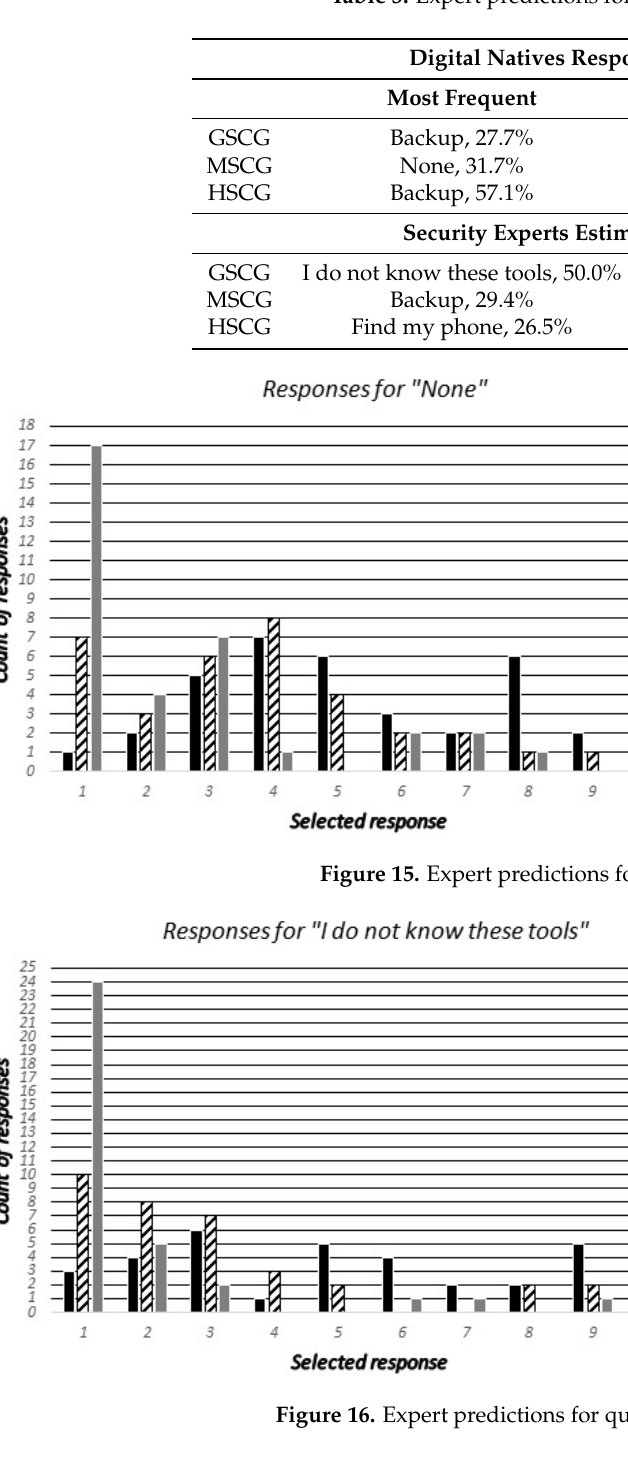
Table 3. Expert predictions for question 11.